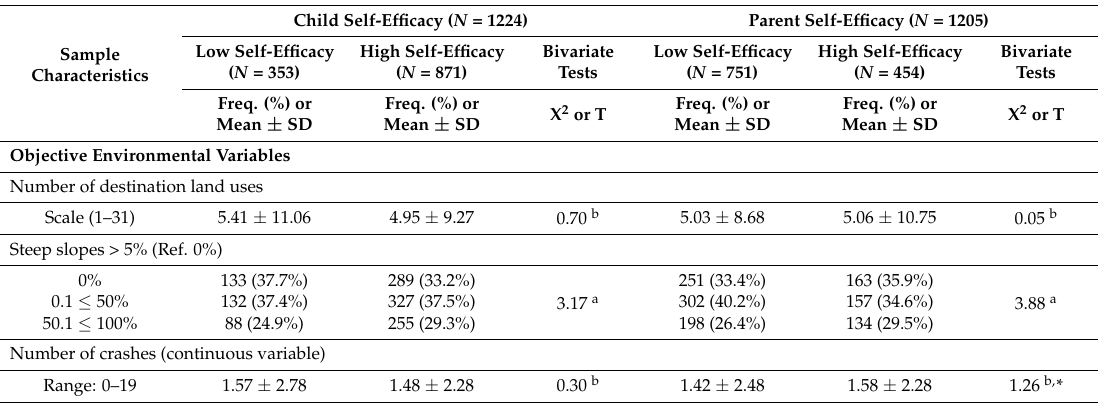
Table 4. Fully adjusted models estimating the odds of having “high self-efficacy”.